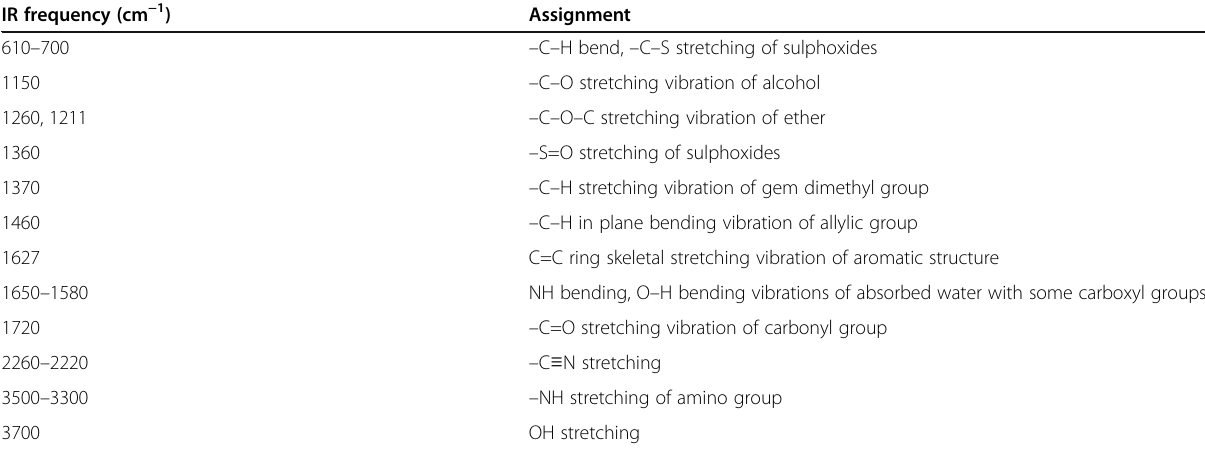
Table 1 FTIR signatures and assignment of FTIR signals of VNLAC